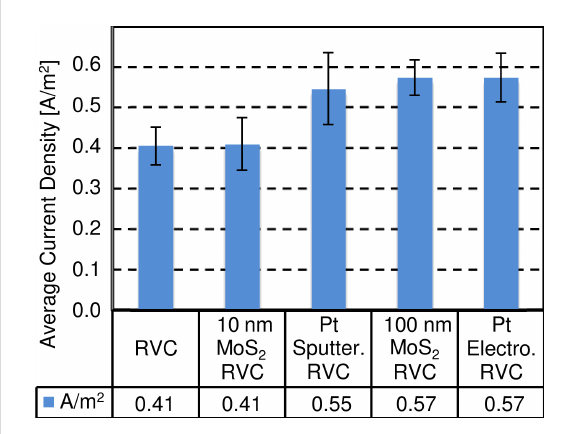
Figure 8: Average current density generated per uncoated and coated electrodes during the 2 h experiments. The currents have been normalized as a function of the RVC area of 21 cm 2 .